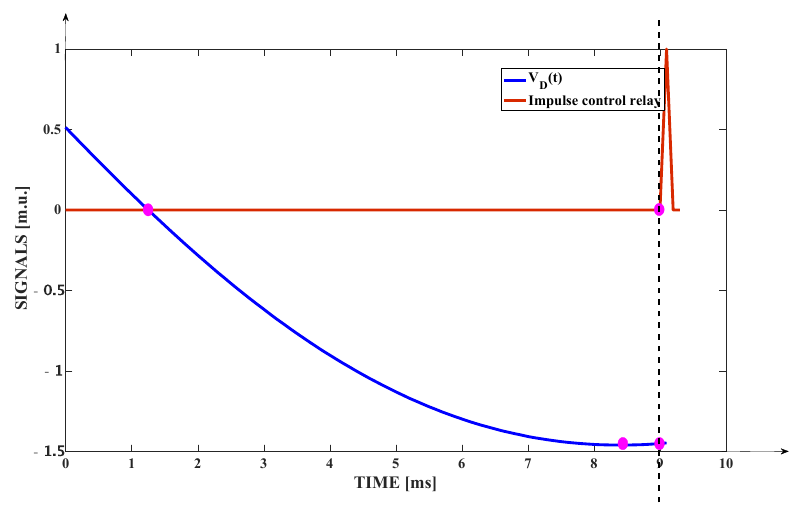
Figure 22. Highlighting the detection of the fault through the dynamics of the V D (t) signal.